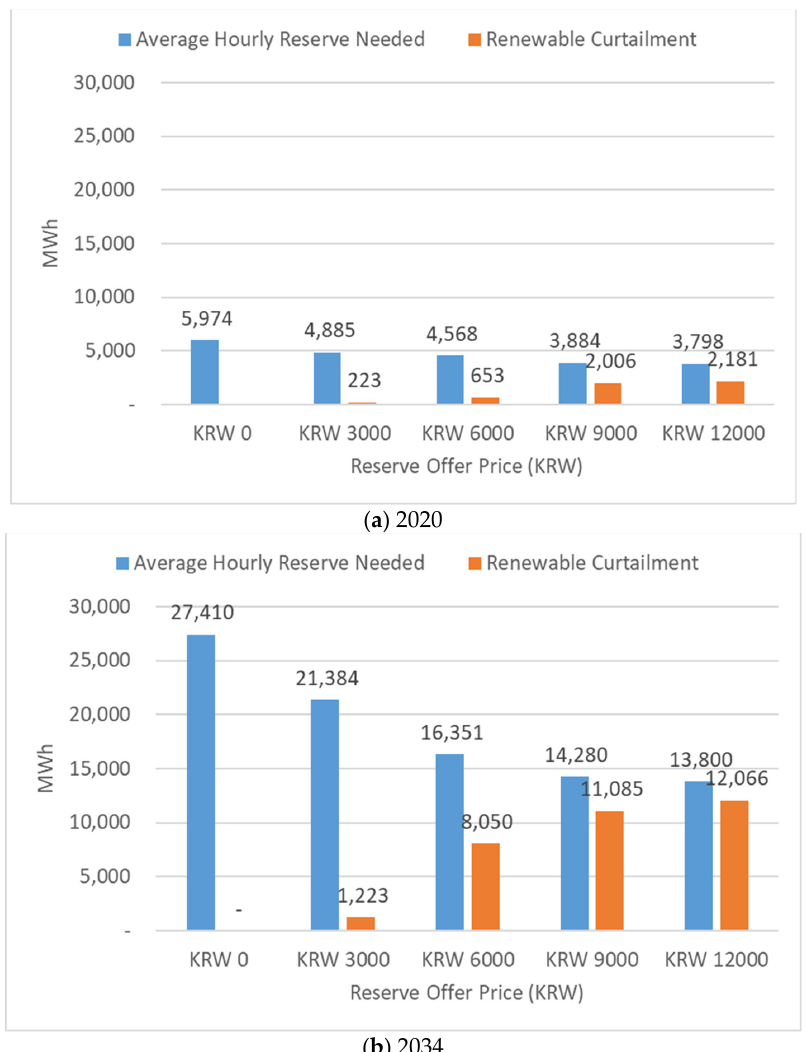
Figure 6. Average hourly reserve requirement and VRS curtailment, 2020 vs. 2034. Figure 7 summarizes the ORDCs of the Korean power system in 2020 and 2034. An ORDC is used to estimate the marginal benefit of an additional unit of reserve, and it provides the basis for properly valuing reserves and determining the relationship be- tween the amount of reserve needed and the reserve price. The ORDC of 2020 presents an extremely inelastic demand curve. The reserve re- quirement does not change considerably with the offer price because VRS penetration is extremely low and its uncertainty is not significant. The ORDC of 2034 is more elastic with considerably higher uncertainty due to VRSs, and therefore, the amount of reserve needed to cover this uncertainty varies significantly with reserve price. As depicted in Figure 6, when the reserve price is higher, the power system is optimized by reducing the reserve needed and curtailing VRS generation to balance the system. The ORDC of 2034 shows that when the reserve price increases from 0 KRW to 9000 KRW, the amount of reserve needed decreases rapidly because other alternatives, such as VRS curtailment, can provide